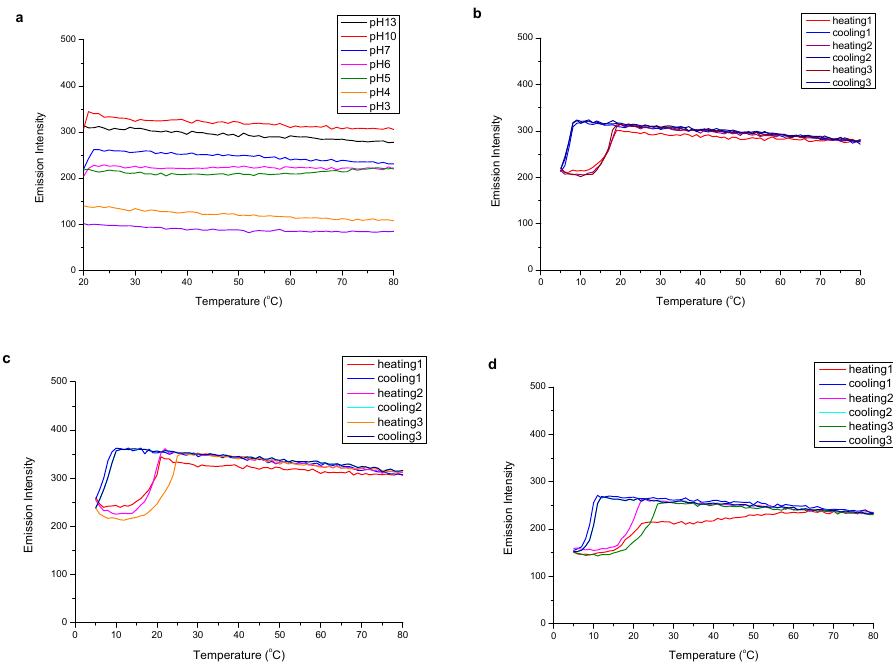
Figure 4. Fluorescence emission as a function of temperature at different pH values ( a ) PMEE-PDTriG. Thermal stability with heating and cooling cycles of PMEE-PDTriG at ( b ) pH = 13; ( c ) pH = 10; ( d ) pH = 7.